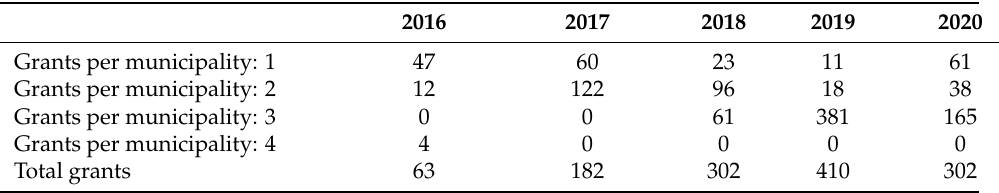
Table 5. Number of grants in municipalities for each